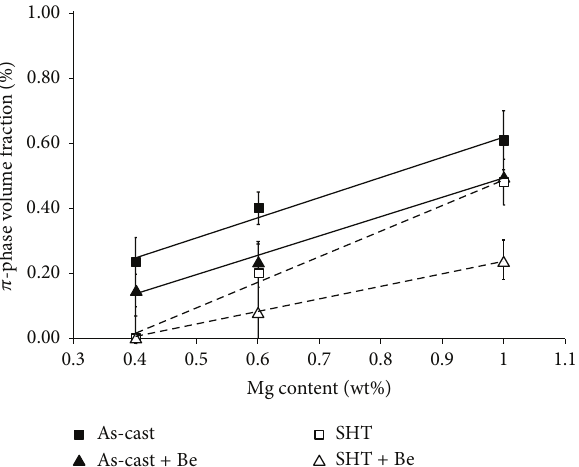
Figure 1: An example of the effect of Be addition on the volume fraction of the 𝜋 -phase in nonmodified Al-7Si- 𝑥 Mg-0.1Fe Be- containing alloys [5].